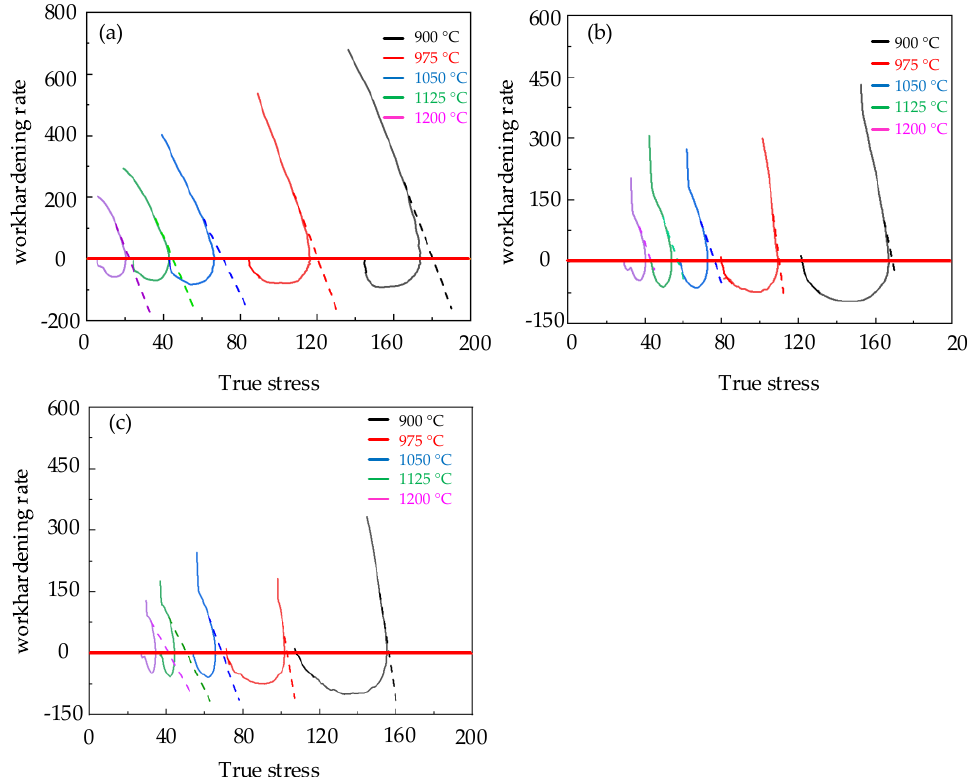
Figure 8. Relation curve of θ − σ of Cr8 steel under different temperatures and strain rates: ( a ) ε = 0.1 s − 1 ; ( b ) ε = 0.01 s − 1 ; ( c ) ε = 0.005 s − 1 .